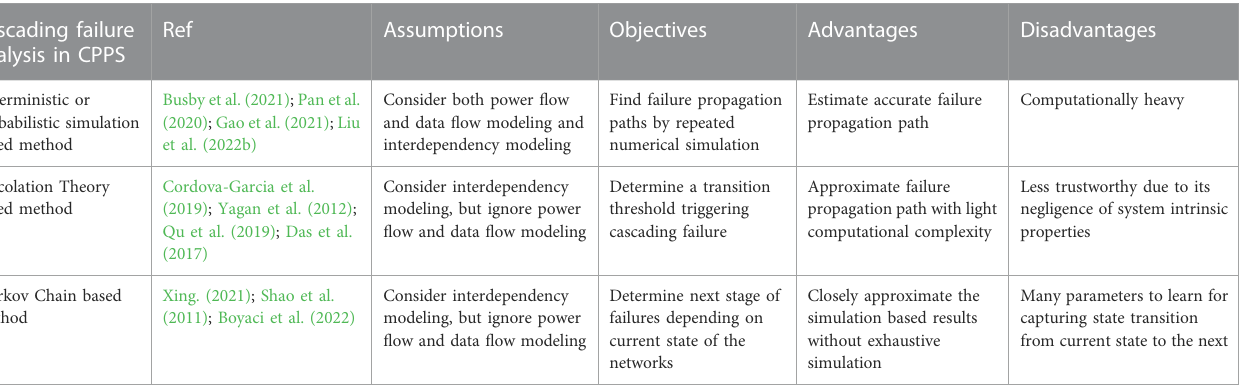
TABLE 2 Comparison of cascading failure analyses in